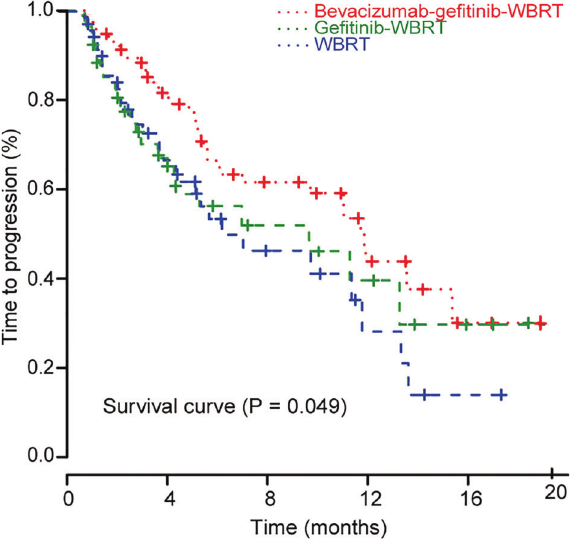
Figure 2. Kaplan-Meier estimation of progression-free survival in patients with brain metastases due to non-small-cell lung cancer treated with bevacizumab-ge fi tinib-WBRT, ge fi tinib-WBRT and WBRT. WBRT: whole brain